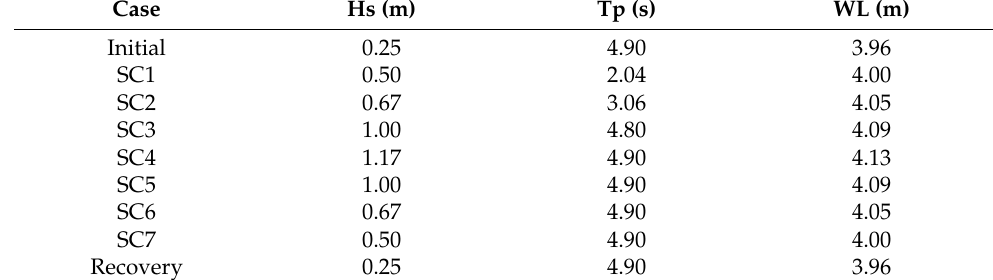
Table 1. Incident wave and water level conditions for each step. Hs, Tp, and WL denote significant wave height, peak period, and water level, respectively [9].